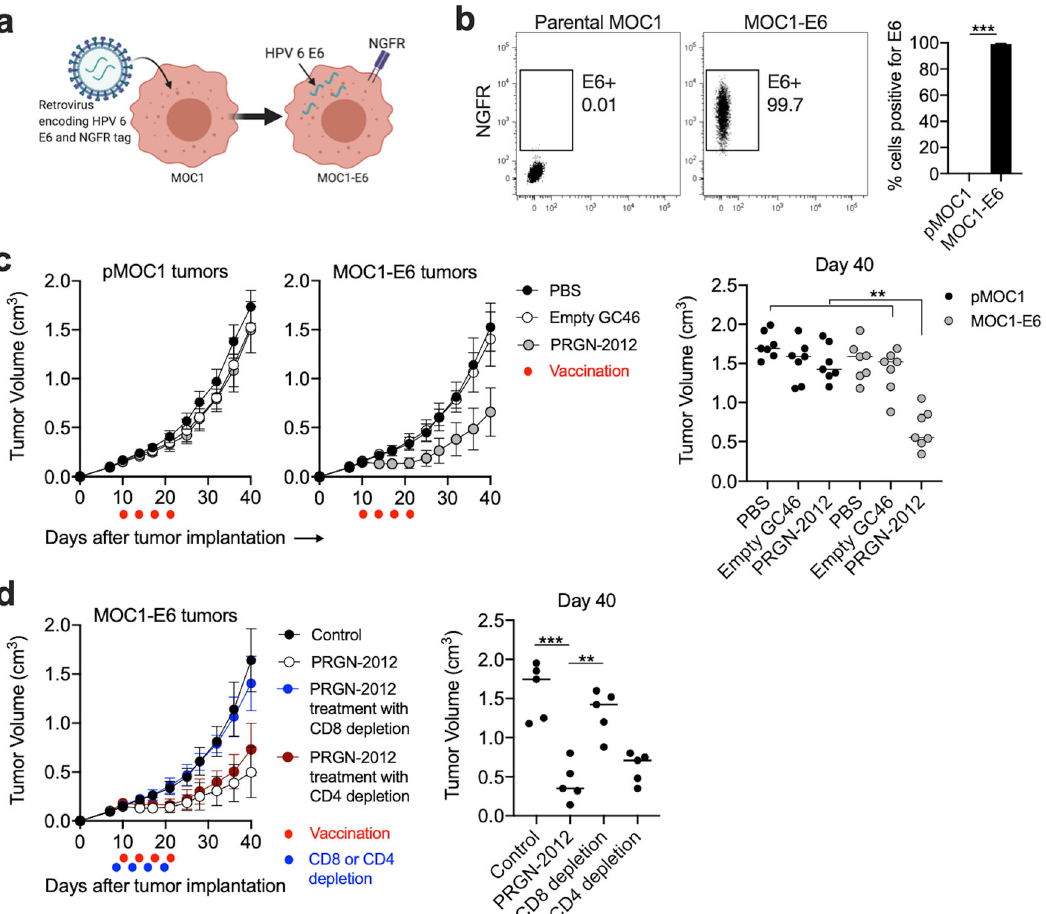
on the right. d Summary growth curves of mice bearing MOC1-E6 tumors treated with PRGN-2012 in the presence or absence of CD8 or CD4 depleting antibodies. Red dots indicate treatments and blue dots indicate depletions. Day 40 tumor volumes are individually quanti fi ed on the right. Similar results were observed in two independent experiments. NGFR nerve growth factor receptor. ** p < 0.01; *** p < 0.001; Student ’ s t test or